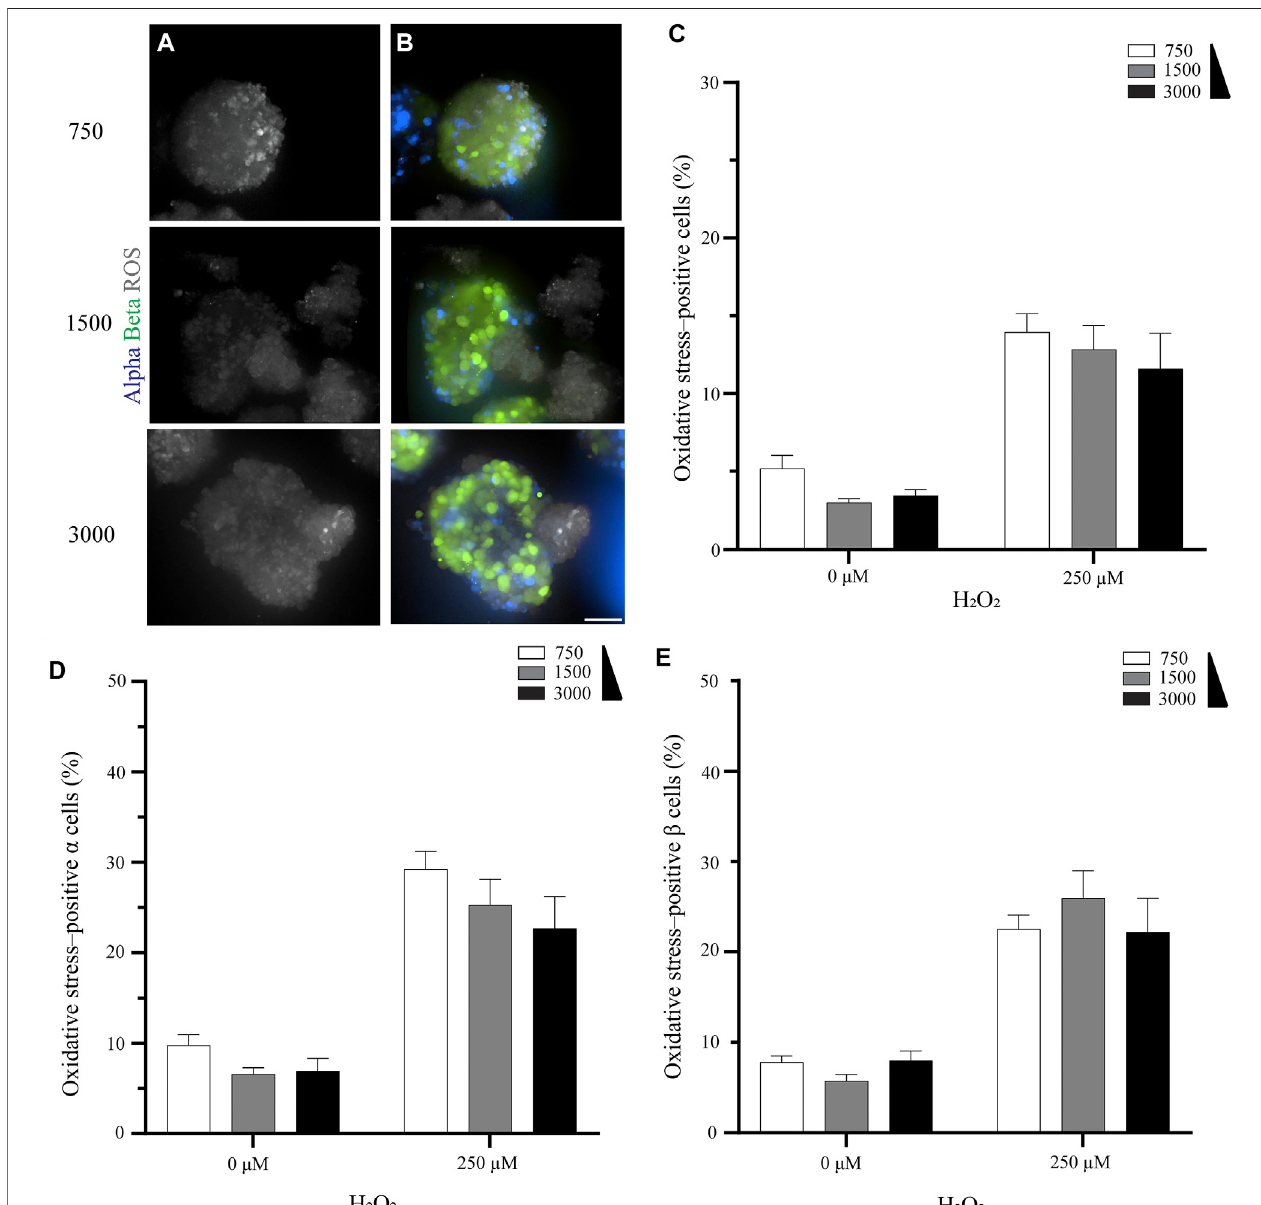
FIGURE2| Thepseudoisletsizedoes notaffect the percentage ofoxidativestress-positivecells (A) Fluorescenceimagingofthe differentsizedpseudoislets(750, 1,500 and 3,000 cells) and the oxidative stress-positive cells in pseudoislets exposed to 250 µM H 2 O 2 (B) The different sized pseudoislets showing α cells (blue), β (green) and ROS (grey). Scale bars: 50 µm (C) The percentage of oxidative stress-positive cells in differently sized pseudoislets was not affected by the induction of oxidative stress with H 2 O 2 (D) The percentage of oxidative stress-positive α cells was 22.7 – 29.2% (E) The percentage of oxidative stress-positive β cells was 22.2 – 26.0%. Results are expressed as mean ± SEM, and each data set includes fi fteen pseudoislets (n:15), and the experiment was repeated three times